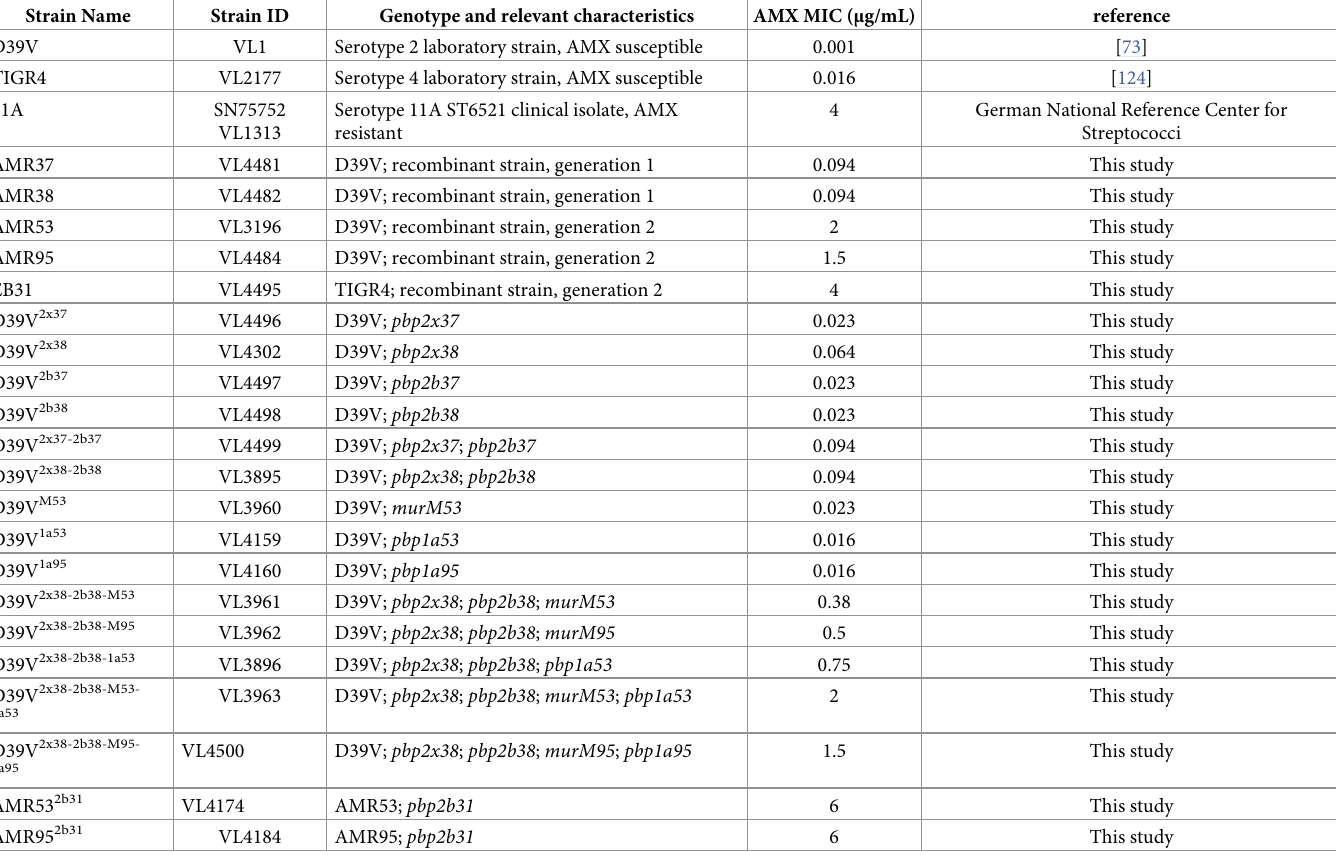
Table 1. Key strains used in this study. The full collection of recombinant strains and their AMX MIC can be found in S1 Table.